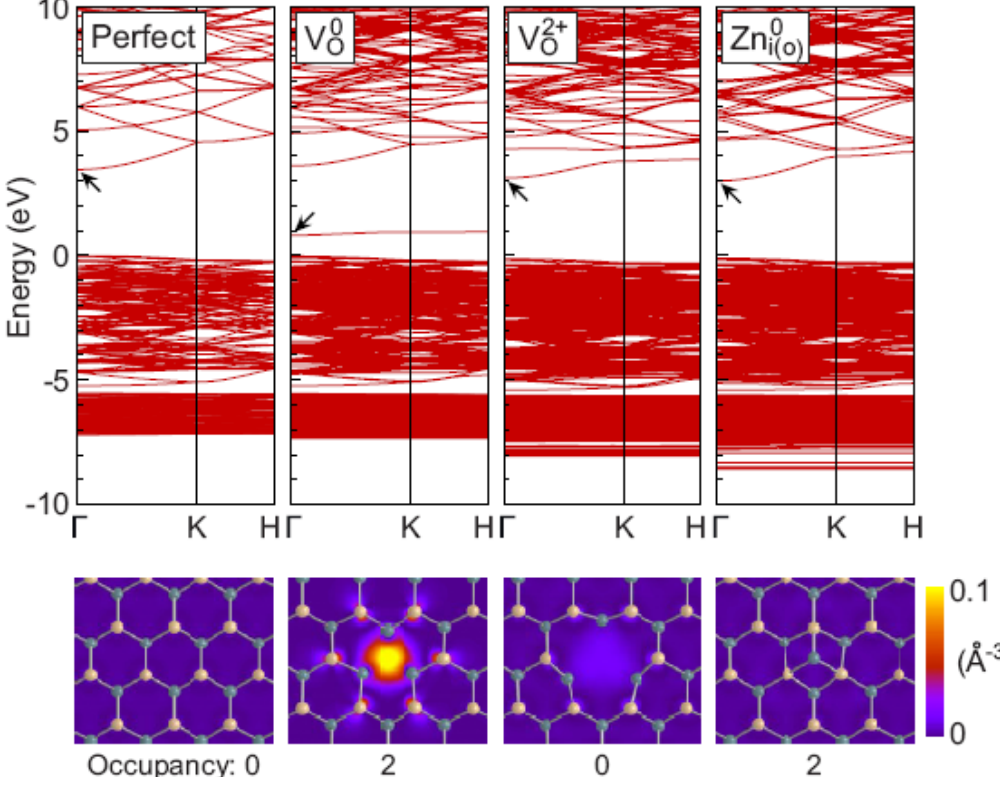
Figure 10. Band structure for bulk ZnO and defects 0 was obtained using the hybrid functional. Shown below are the squared wave functions of the states designated by the arrows in the corresponding band diagram, which are plotted for the middle of the (0001) Zn and O planes adjacent to the defects. The projected Zn and O atom positions are denoted with green (dark) and yellow (light) circles, respectively. Reprinted from Ref. [62] with